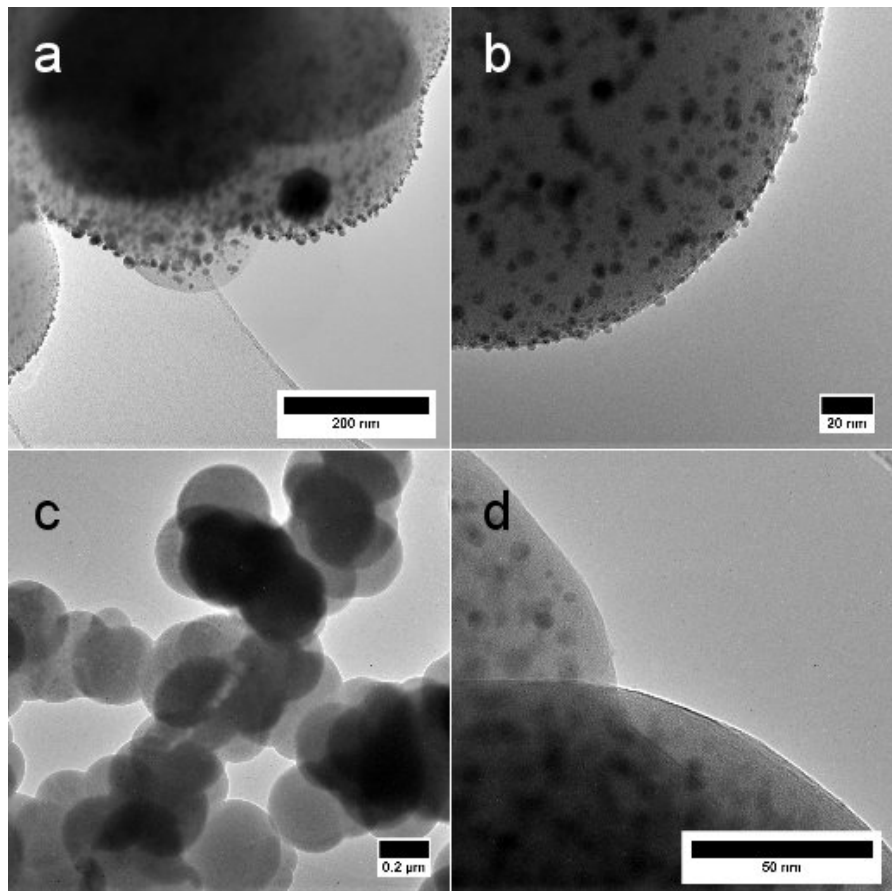
Figure 7. TEM images of SiO 2 -Ag 600 powder ( a , b ) and the Ag dissolved from the surface by HNO 3 from the SiO 2 -Ag 600 powder. The lighter parts represent the silica matrix, whereas the darker spots are silver particles. Scale bars in ( a ) 200 nm; ( b ) 20 nm; ( c ) 0.2 µ m and ( d ) 50